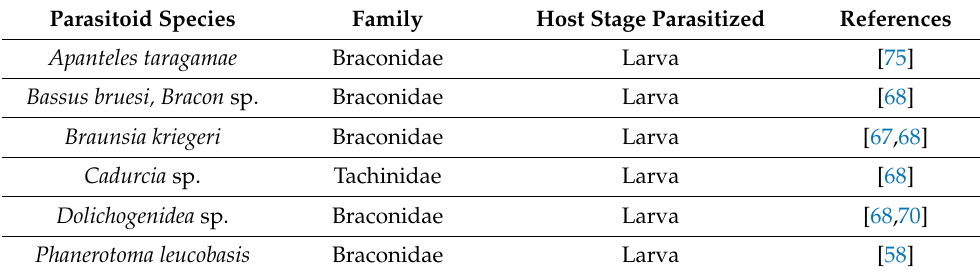
Table 3. Parasitoids of Maruca vitrata that have been reported in SSA. Parasitoid Species Family Host Stage Parasitized